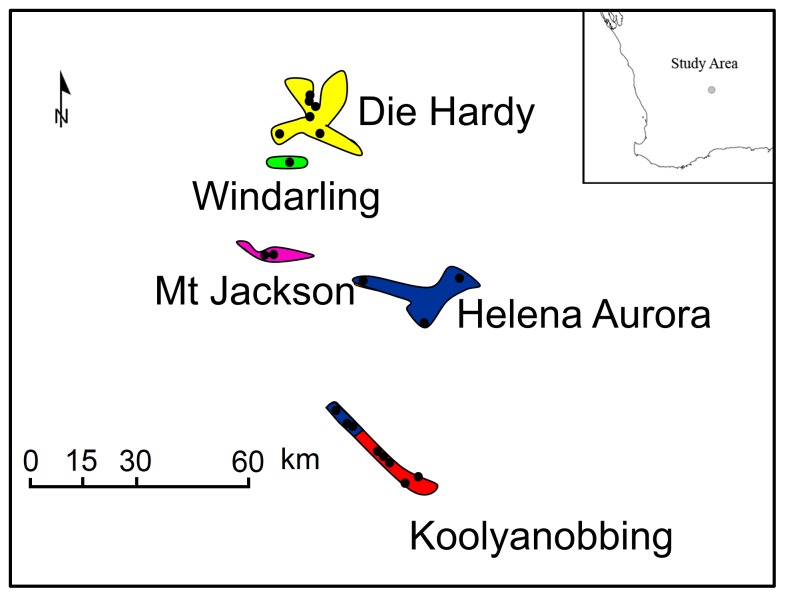
Schematic representation of the five Atelomastix bamfordi Banded Iron Formation populations, coloured according to the five genetic clades identified with mtDNA analysis.Black circles indicate sample sites. Study area shown in inset.